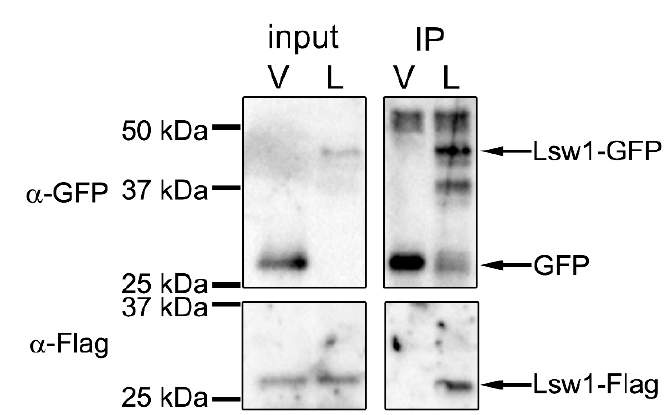
Figure 5. Self-interaction of Lsw1. Δ swi6 cells (YTP1847) containing pRep42-Lsw1-Flag and either pGP4110 (V) or pGP4110-Lsw1 (L) were grown in minimal medium in the absence thiamine at 30 °C for 20 h. The cell lysates were precipitated with anti-GFP antibody, and precipitated proteins were detected by Western blotting using anti-GFP and anti-Flag M2 antibodies.